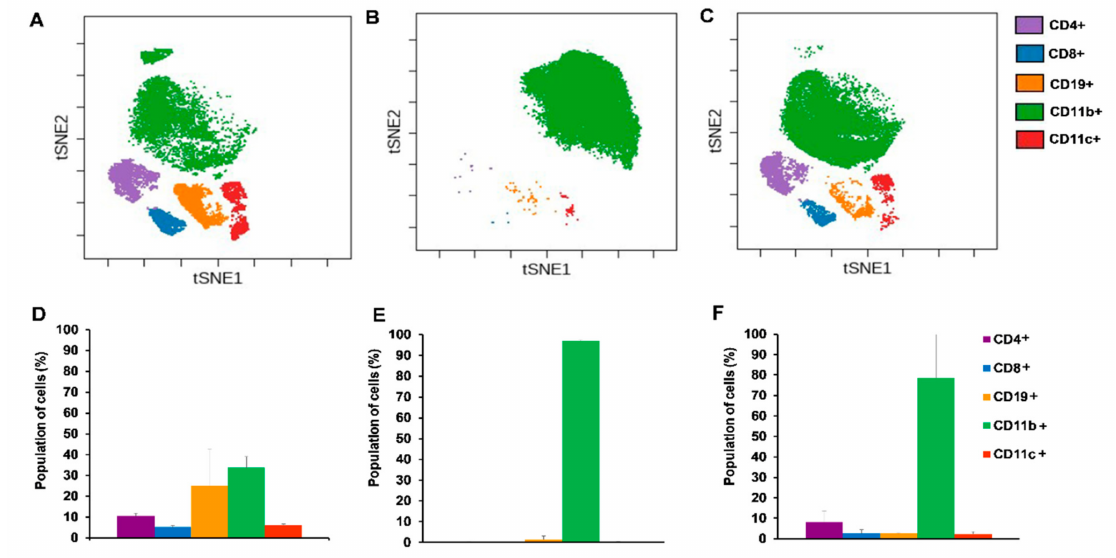
Figure 7. Immunophenotyping of blood showed dramatic expansion of CD11b + cells in advanced cancer. The viSNE analysis was run on the ( A ) naive, ( B ) 4T1 tumor bearing, and ( C ) cisplatin treated 4T1 tumorous animals within the CD45 + living singlets. Quantitative analysis of the main lymphoid subsets: CD4 + T-cells = lilac, CD8 + T-cells = blue, CD19 + B-cells = orange and the myeloid CD11b + = green, CD11c + = red subsets was performed in the blood of ( D ) naive, ( E ) 4T1 tumor bearing, and ( F ) cisplatin treated 4T1 tumorous mice within the CD45 + living singlets. Representative viSNE plots and column bars are shown from the pooled samples of 6 mice per group. Data are shown as arithmetic means on the column bars ± SEM. Pairwise comparison of the emergence of CD11b + population in ( E ) vs. ( D ) has significance at p <